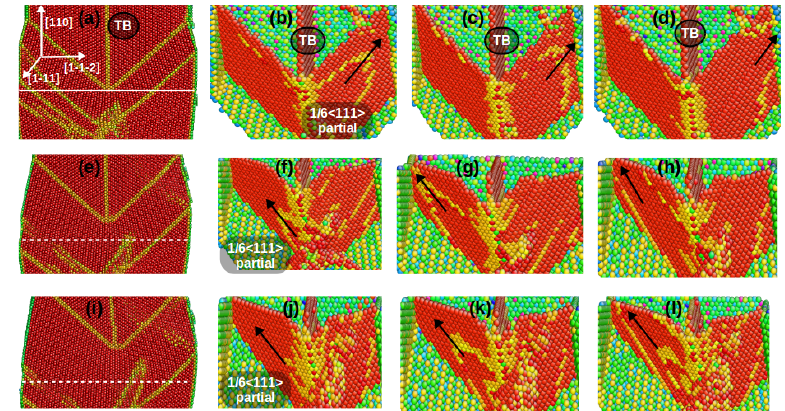
Figure 3. The annihilation of pre-existing twin boundary due to the step-by-step migration of the twin–twin junction ( a , e , i ). The movement of twin-twin junction is aided by the continuous nucleation (from the twin–twin junction) ( b , f , j ) and glide of 1/6 < 111 > partial dislocations on newly formed twin boundaries( c , d , g – h , k , l ). The atoms are coloured according to their centro-symmetry parameter (CSP).